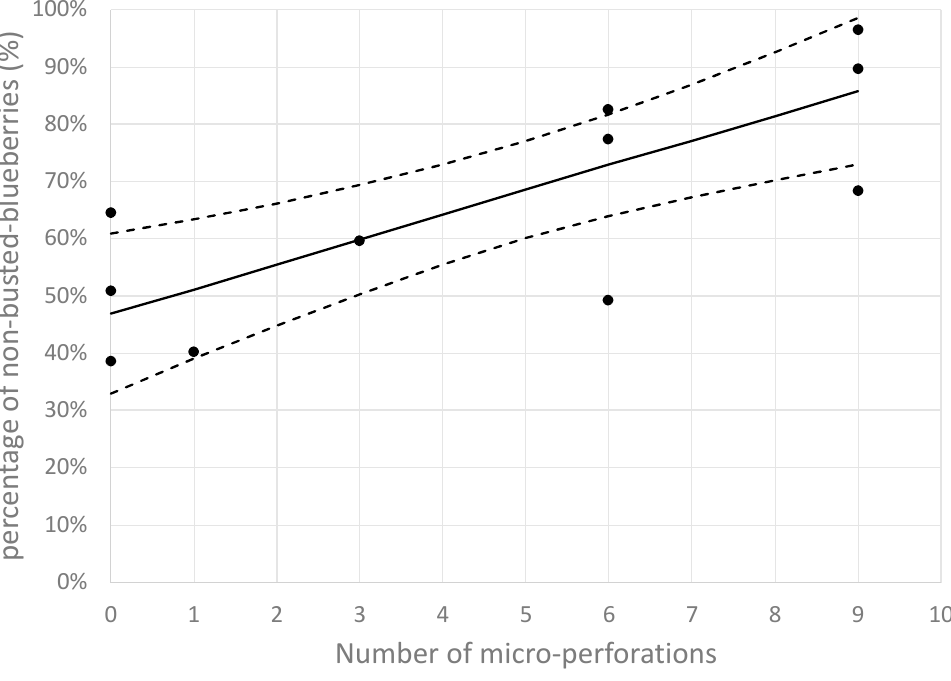
Figure 11. Experimental and statistical analysis of the nonbusted percentage (%) as a ff ected by CO 2 laser